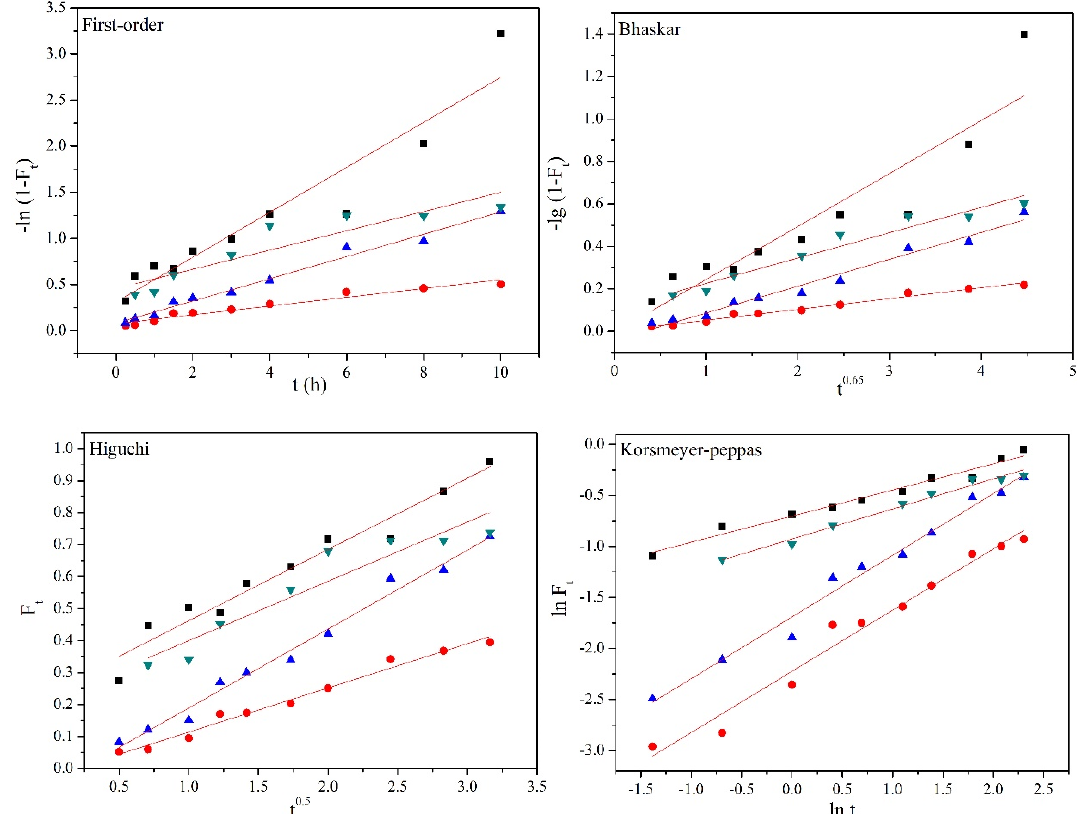
Figure 9. Kinetic plots of First-order, Bhaskar, Higuchi, and Korsmeyer–Peppas models for NAP release from MSN-SS-Fc@ β -CD-PNIPAM nanoparticles. Table 3. Kinetic parameters of drug release in different mediums.